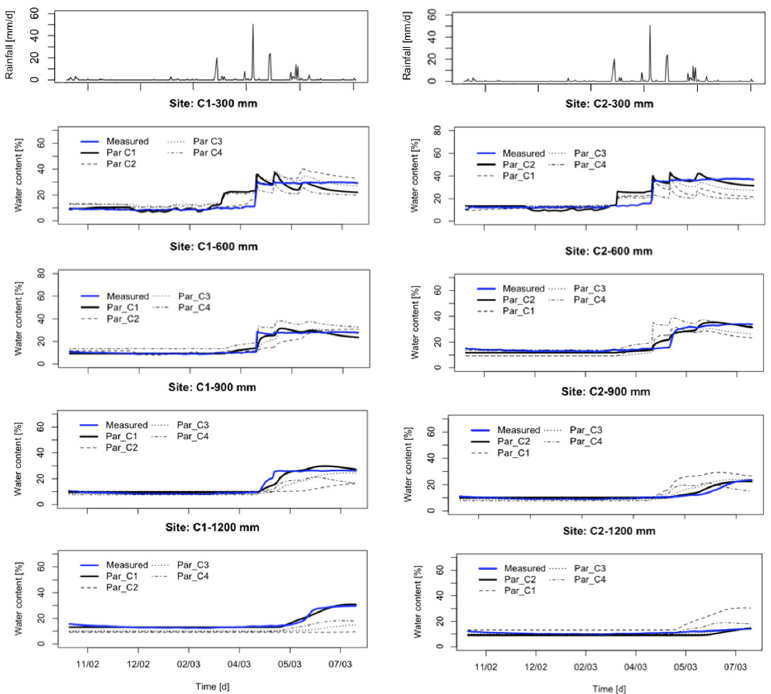
Figure 5. Soil moisture dynamics at different depths (300, 600, 900 and 1200 mm) in locations C1 and C2. The blue bold lines are the measured data. The black lines are simulated SM values computed by using different parameters set (Par_C1, Par_C2, Par_C3, and Par_C4) as specified in the legend.